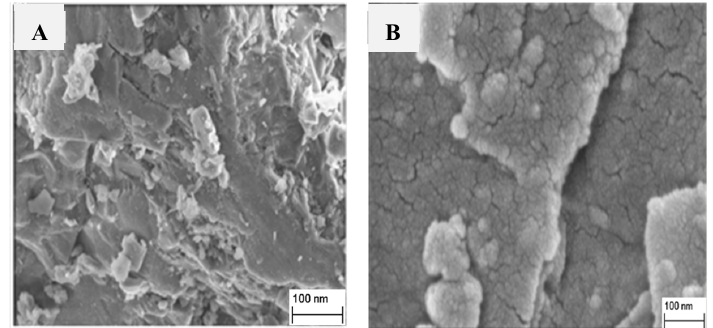
Figure 2. SEM micrographs of ( A ) undoped lithium aluminium borate and ( B ) 0.1% magnesium ‐ doped lithium aluminium borate. doped lithium aluminium